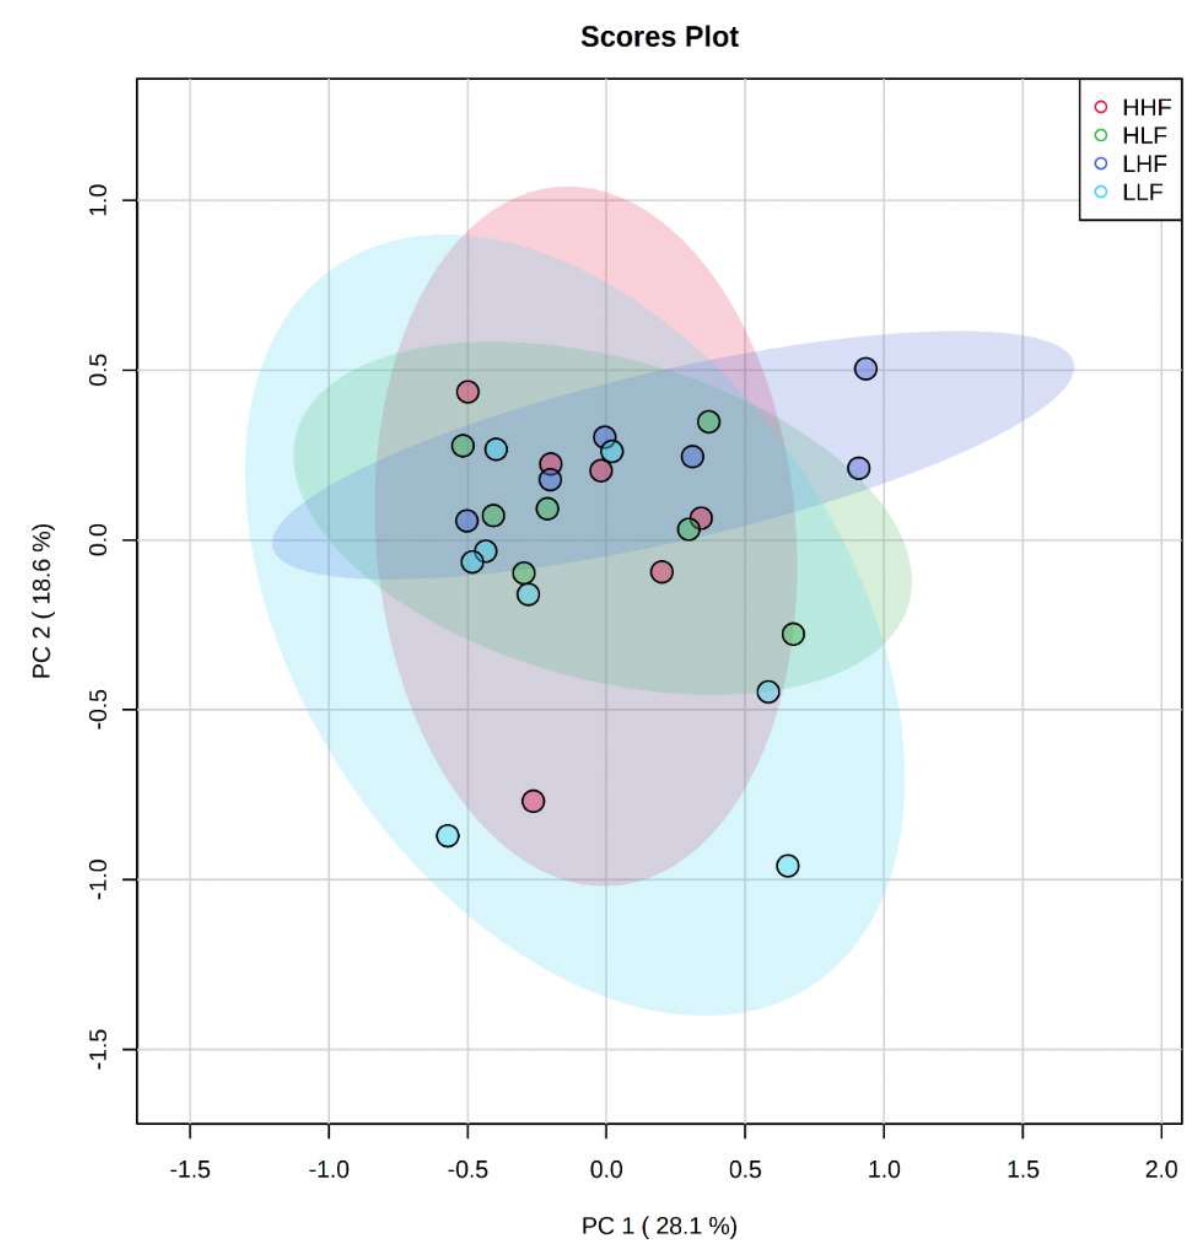
Figure 4. Heatmaps and dendrograms of metabolites in offspring exposed to high maternal and high postnatal LA diets in females (HHF: red), high maternal and low postnatal LA diets in females (HLF: green), low maternal and high postnatal LA diets in females (LHF: dark blue), and low maternal and low postnatal LA diets in females (LLF: light blue). Offspring numbers are indicated on the bottom axis of the graph, whilst the top axis indicates their corresponding group colors. All metabolites have been logarithmically scaled. Heatmap scales are denoted by red being higher concentrations, blue being lower, with white residing in the middle. Pearson clustering algorithm used for dendrograms to indicate relationships between metabolites in the cohort.